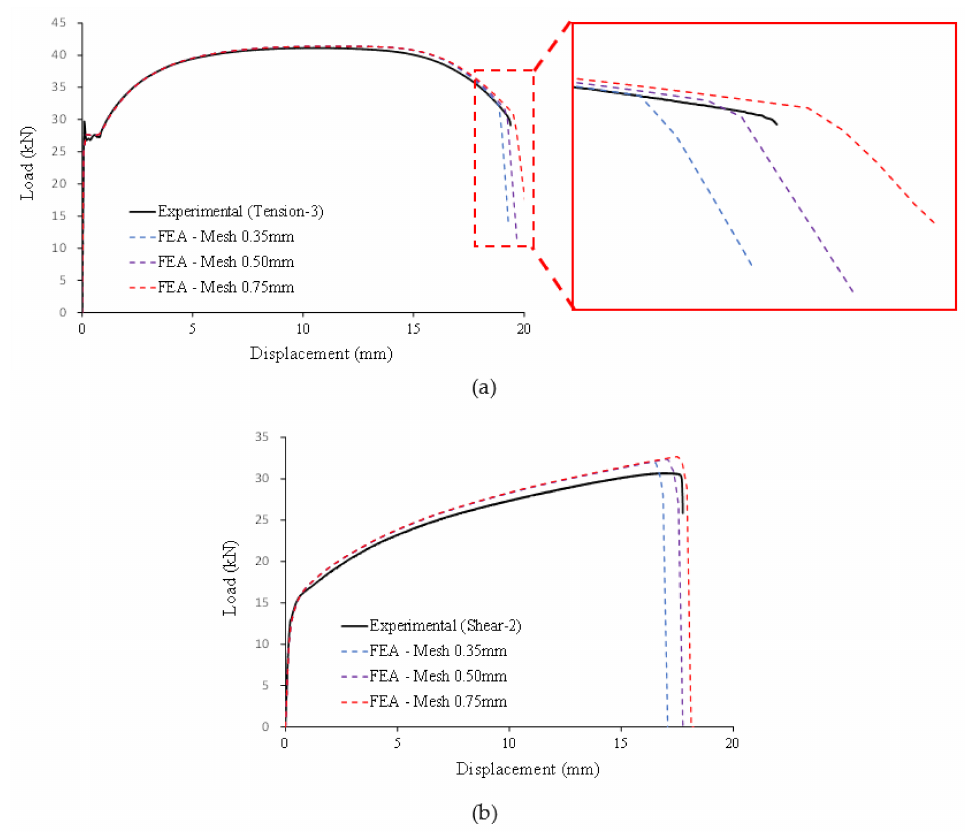
Figure 9. Results of mesh sensitivity analysis: ( a ) Specimen Tension-3; ( b ) Specimen